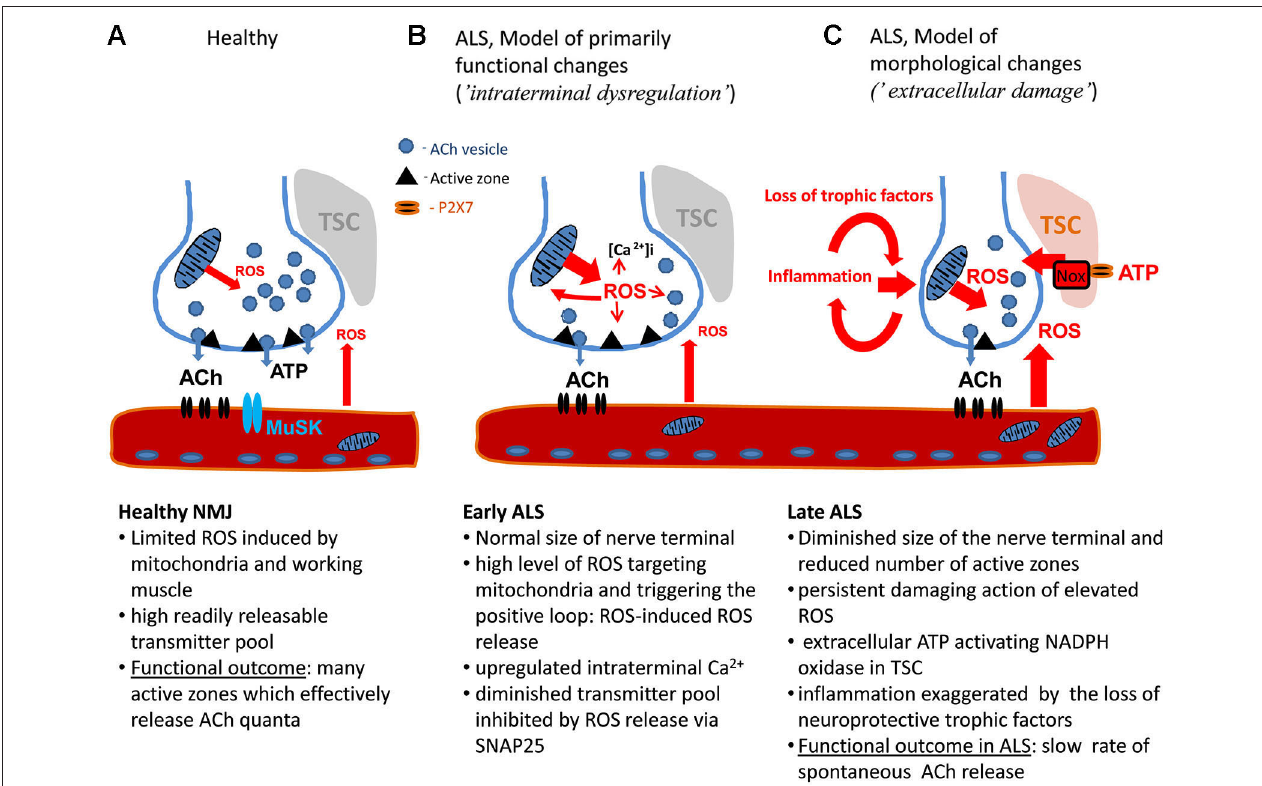
ALS. ACh: Acetyl choline, MuSK: muscle-specific kinase, NMJ: Neuromuscular junction, ROS: Reactive oxygen species, TSC: Terminal Schwann